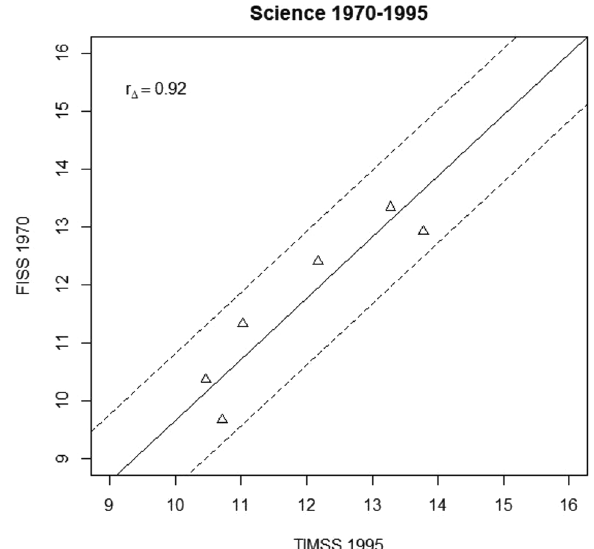
Fig. 9 Delta plot of the bridge between FISS and TIMSS